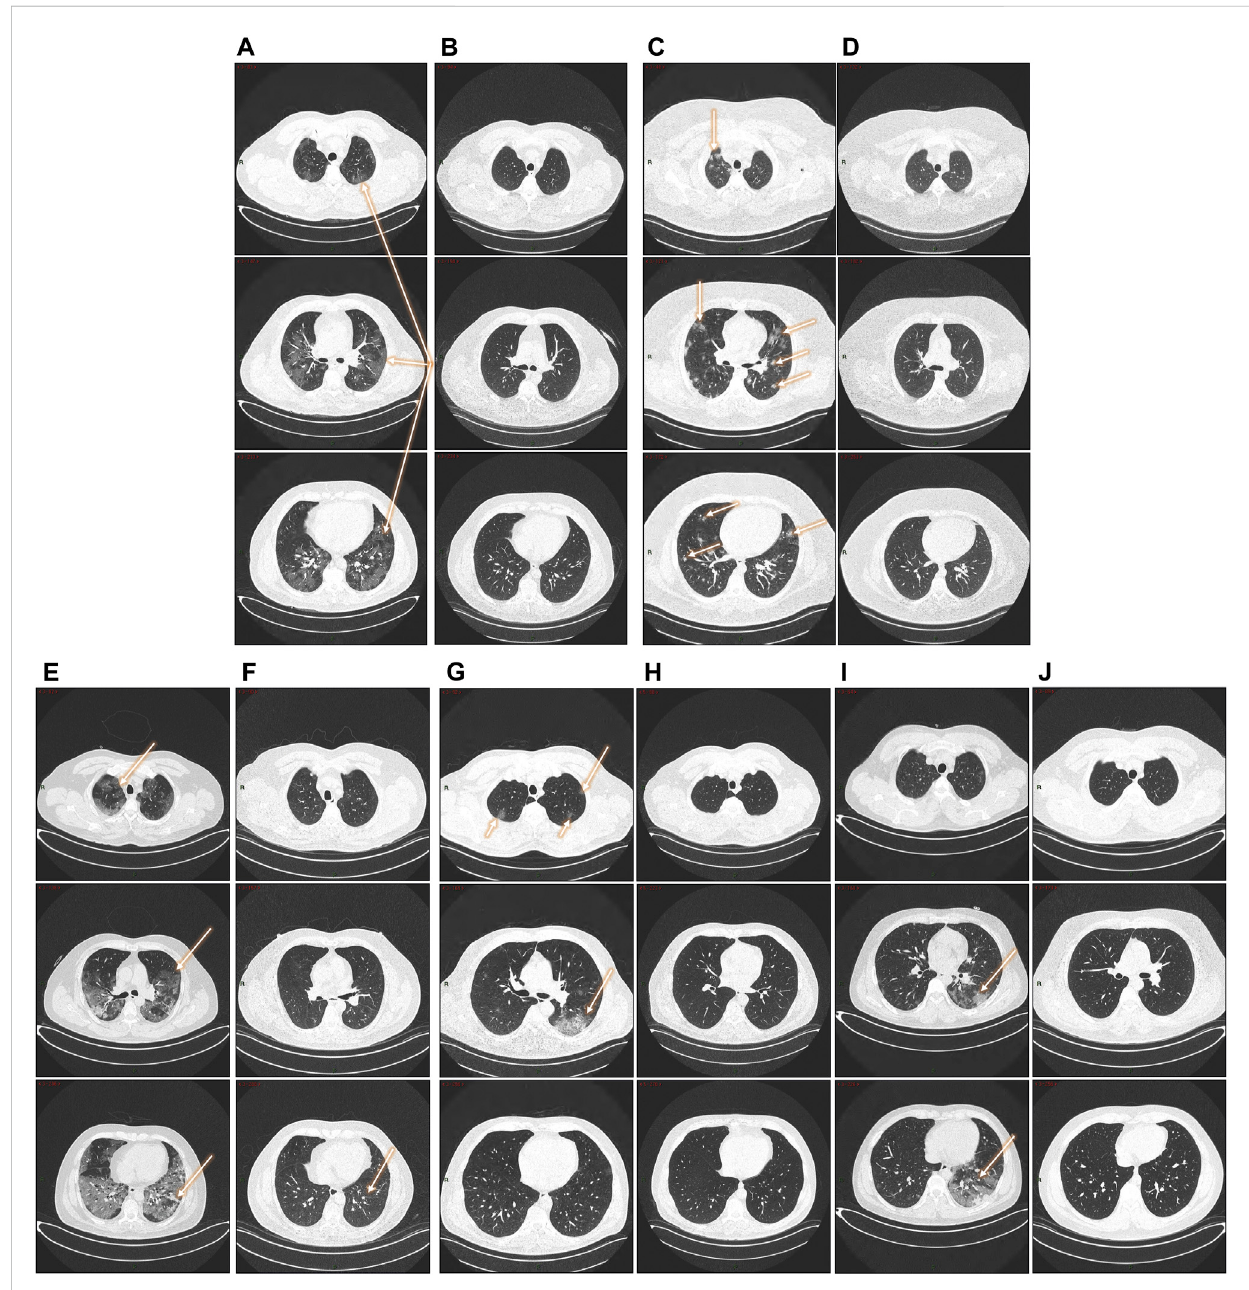
FIGURE 2 Follow-up lung CTs in patients with different degree of severity. (A, B): 47-year- old male patient (severe disease). (A) 2020. Pneumonia with presenceofagroundglasspatterninthethreelevelsoftheparenchyma,withapredominantinjuryintheleftbasalregion(arrows)withscatteredareasof consolidation. (B) 2022. Complete resolution of radiological fi ndings. (C, D): fi ve- year-old male patient (severe disease). (C) 2020. Multiple nodular opacitiesintherightupperlobe(arrow)withgroundglassimagesinthemiddleleveloftheparenchyma(coronalsection)andpredominancetheleft lobe. At the basal level, the affected areas are smaller with a diffuse nodular pattern. (D) Complete resolution of radiological fi ndings. (E, F) : 51-year- old male patient (severe disease). (E) 2020. Pneumonia with the presence of a pattern in ground glass patches in the three levels of the parenchyma, with injury predominantly in the left basal region (arrows) with areas of consolidation and a pattern of bronchoalveolar distention. (F) 2022. Almost complete resolution of COVID-19 pneumonia with a mild residual interstitial pattern, predominantly at the basal level, coronal section (arrow). (G, H): 51-year-old male patient (severe disease). (G) 2020. Ground glass-type opacities are identi fi ed in the middle level of the parenchyma in coronal section, left lobe (arrow).Attheapicalregion,adiffusepatternofcotton-nodularappearance. (H) 2022.Completeresolutionoftheradiological fi ndings. (I,J): 30-year-old male patient (severe disease). (I) 2020. Pneumonia with presence of a minimally affected pattern in the apical area with barely perceptible frosted glass smears,diffuseground-glasspatchesatthemid-leveloftheparenchyma,withconsiderableinvolvementofleftbasalregion(arrows). (J) 2022:Complete resolution of radiological fi